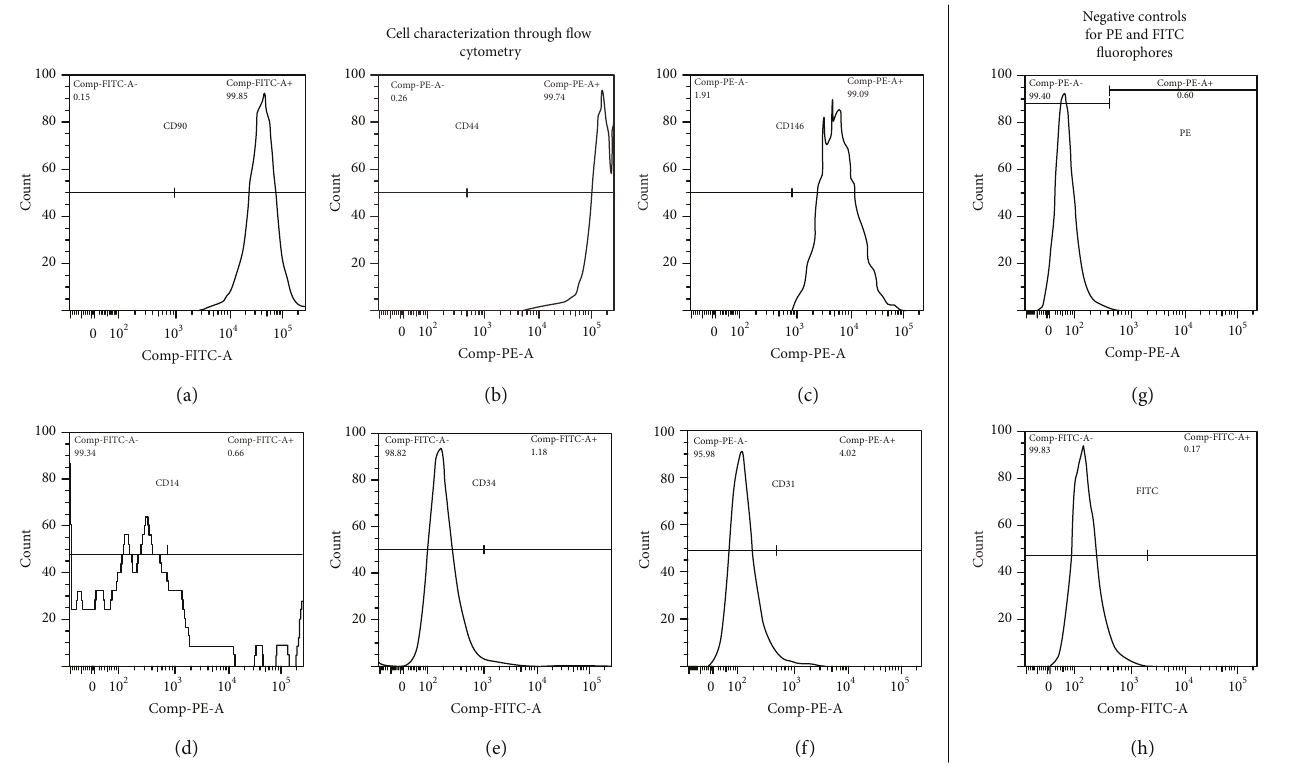
Figure 1: Cell characterization through fl ow